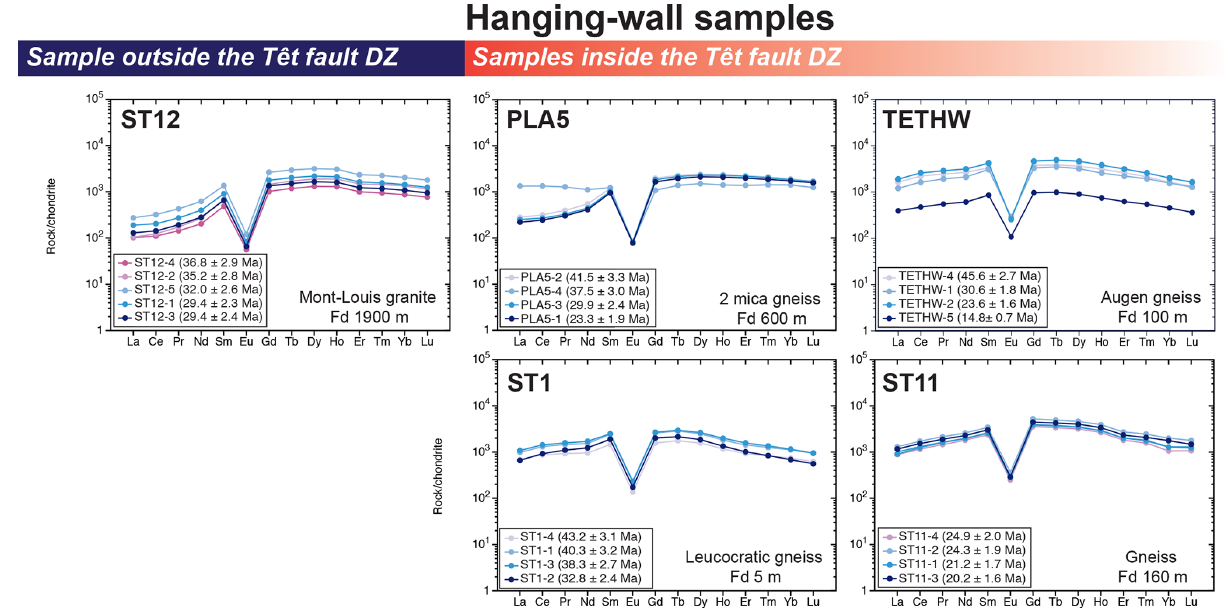
Figure 9. Chondrite-normalized REE patterns (Sun and McDonough, 1989) for the Têt fault hanging-wall samples. REE patterns are reported for samples outside and inside the DZ. Fd: fault distance.